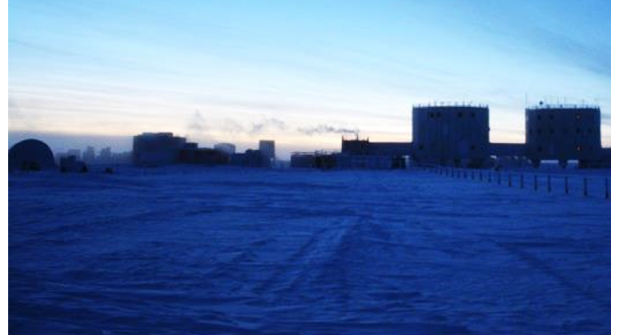
Figure 3. Photograph of Concordia Station illustrating the disper- sion of the exhaust plume from the electrical power generating plant during conditions with a strong surface temperature inversion. The plume dissipated toward the west in the direction of the experimen- tal site. This is a typical situation for a contamination